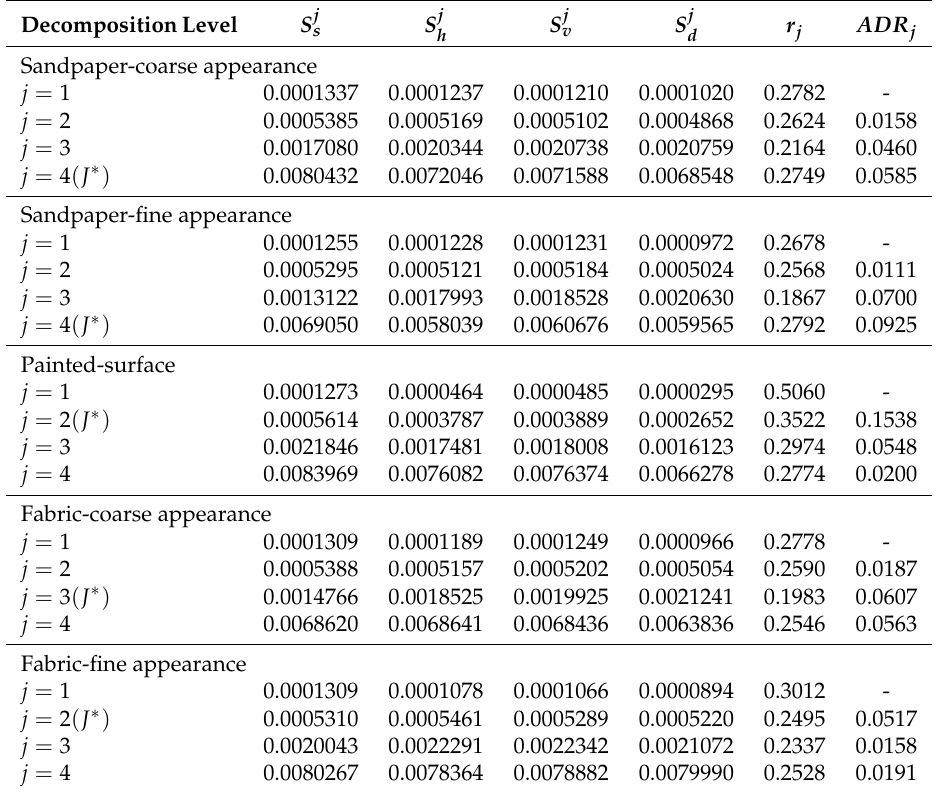
Table 2. Normalized entropies of four decomposition levels for statistical and structural isotropic textures of Figure 8. The optimal resolution level determination ( J ∗ ) is highlighted for every